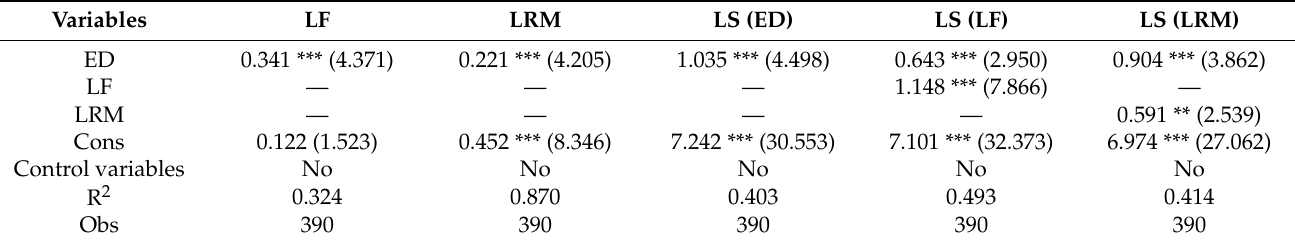
Table 6. Intermediary effect estimation